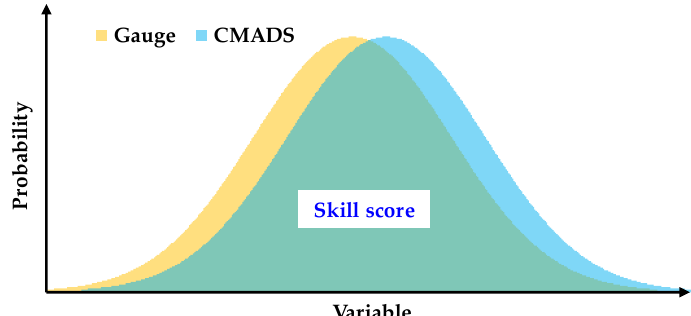
Figure 4. Diagrams of CMADS- probability density functions (PDF) vs Gauge-PDF illustrating the total skill score.